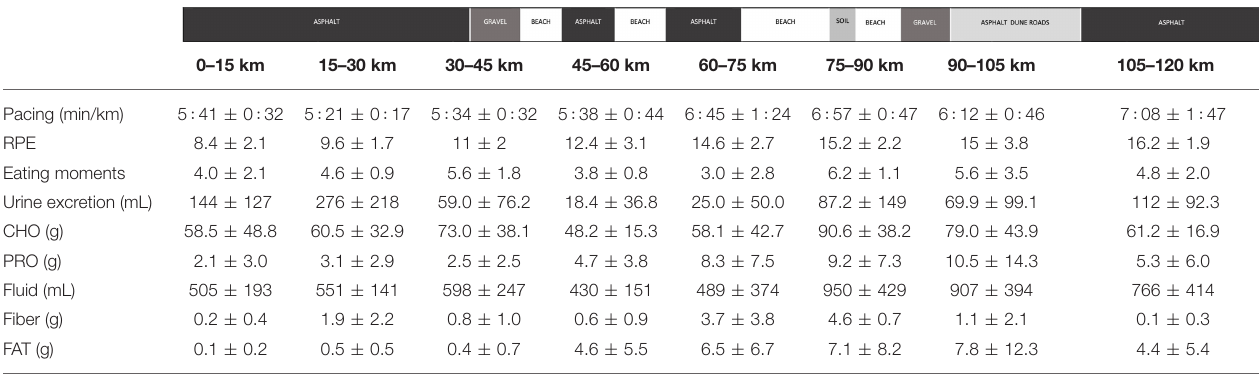
TABLE 3 | Surface, Pacing, rate of perceived exertion, eating moments, fluid excretion, and nutrient intake per 15km ( n =